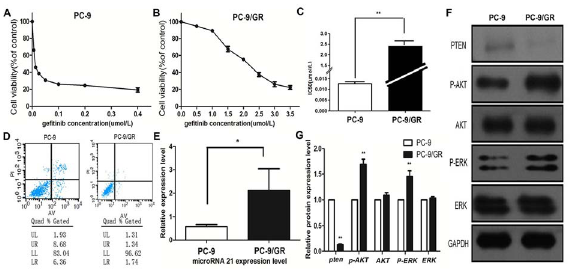
Figure 4. Effects of transient enhanced expression of miR-21 mimics and Pten rescue in Pc 9 cell lines. (A) Relative expression levels of miR-21 in pc-9/NC + pCMV 6 transfected cells, pc-9/miR-21 mimic + pCMV 6 transfected cells and pc-9/miR-21 mimic + Pten plasmid transfected cells were assessed by stem-loop qRT-PCR, and normalized to U6 levels. Triplicate assays were performed for each RNA sample. Significant differences are indicated by **(P , 0.01). (B) gefitinib sensitivity of pc-9/NC + pCMV 6 transfected cells, pc-9/miR-21 mimic + pCMV 6 transfected cells and pc-9/miR-21 mimic + Pten plasmid transfected cells were evaluated by CCK-8 assay. (C) IC50 for gefitinib in pc-9/NC + pCMV 6 transfected cells, pc-9/miR-21 mimic + pCMV 6 transfected cells and pc-9/miR-21 mimic + Pten plasmid transfected cells. **P , 0.001, # P , 0.01. (D) pc-9/NC + pCMV 6 transfected cells, pc-9/miR- 21 mimic + pCMV 6 transfected cells and pc-9/miR-21 mimic + Pten plasmid transfected cells were used for cell invasion assays. Invasion cells stained by 0.1% crystal violet were counted 24 h after plating. Upper panels: representative photographs of invasive cells ( 6 200). (E) Number of invasive cells per field was obtained from at least three replicate wells and represented by mean 6 SD (bottom graph). **indicates significant difference between pc-9/NC + pCMV 6 transfected cells and pc-9/miR-21 mimic + pCMV 6 transfected cells (P , 0.01). ## indicates significant difference between pc-9/miR-21 mimic + pCMV 6 transfected cells and pc-9/miR-21 mimic + Pten plasmid transfected cells (P , 0.01). (F) Apoptosis rates of pc-9/NC + pCMV 6 transfected cells, pc- 9/miR-21 mimic + pCMV 6 transfected cells and pc-9/miR-21 mimic + Pten plasmid transfected cells induced by gefitinib were evaluated by flow cytometry. All cells were treated with 1 m mol/L gefitinib for 72 hours before apoptosis evaluation. (G) Pten, p-AKT, AKT, p-ERK, and ERK proteins of pc-9/NC + pCMV 6 transfected cells, pc-9/miR-21 mimic + pCMV 6 transfected cells and pc-9/miR-21 mimic + Pten plasmid transfected cells were analyzed by Western blot. (H) Quantification of western blot analysis showed down-regulation of Pten protein in PC-9/ 21 mimics + pCMV 6 transfected cells compared with PC-9/NC + pCMV 6 transfected cells (*P , 0.05) and pc-9/miR-21 mimic + Pten plasmid transfected cells ( # P , 0.05); p-AKT and p-ERK proteins expression were up-regulated in PC-9/21 mimics + pCMV 6 transfected cells compared with pc-9/NC + pCMV 6 transfected cells (*P , 0.05) and pc-9/miR-21 mimic + Pten plasmid transfected cells ( # P , 0.05). There were no significant differences in total AKT and total ERK proteins among the three